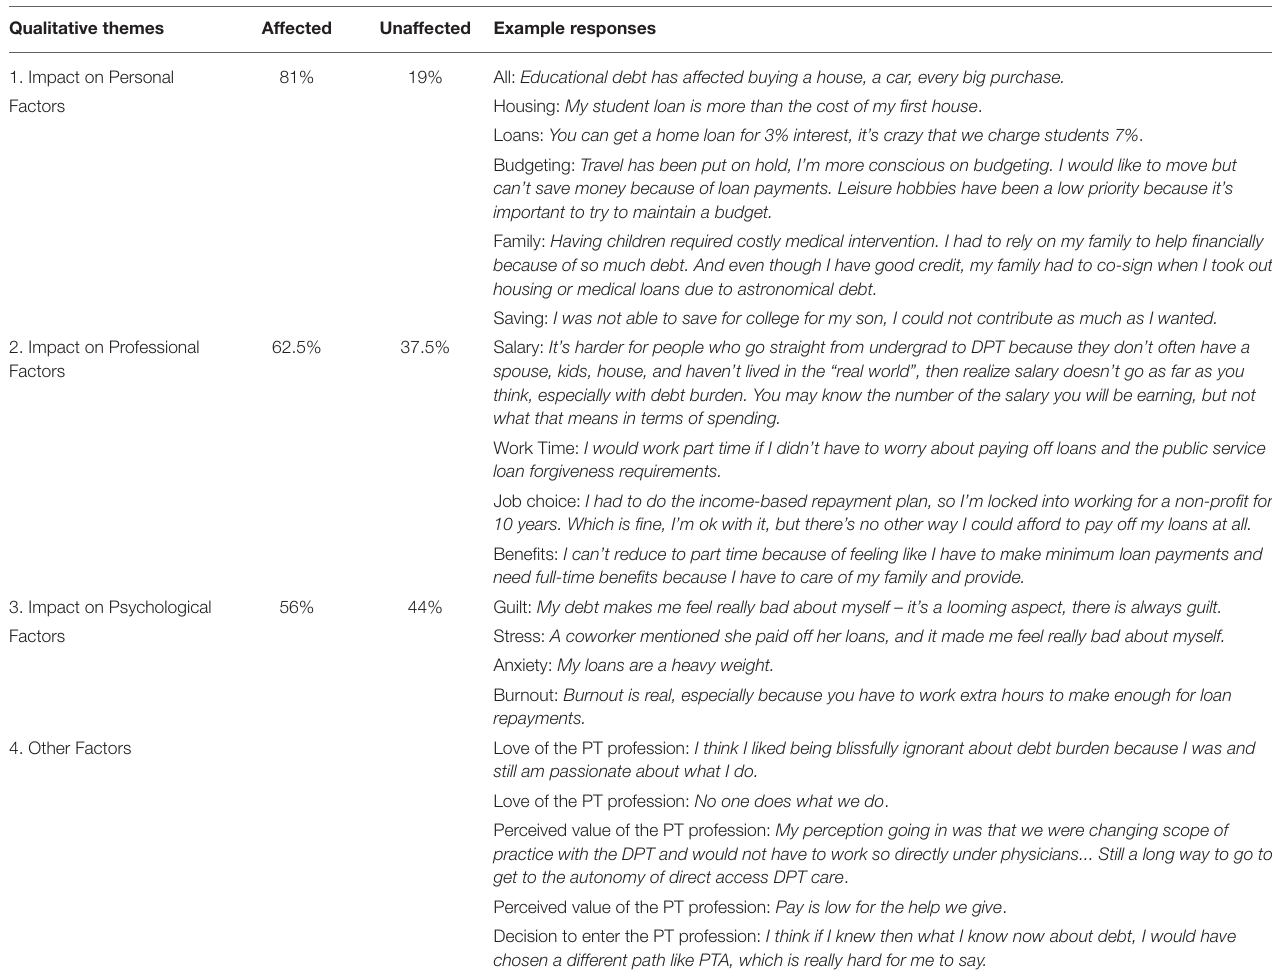
TABLE 5 | Qualitative themes and example responses. Qualitative